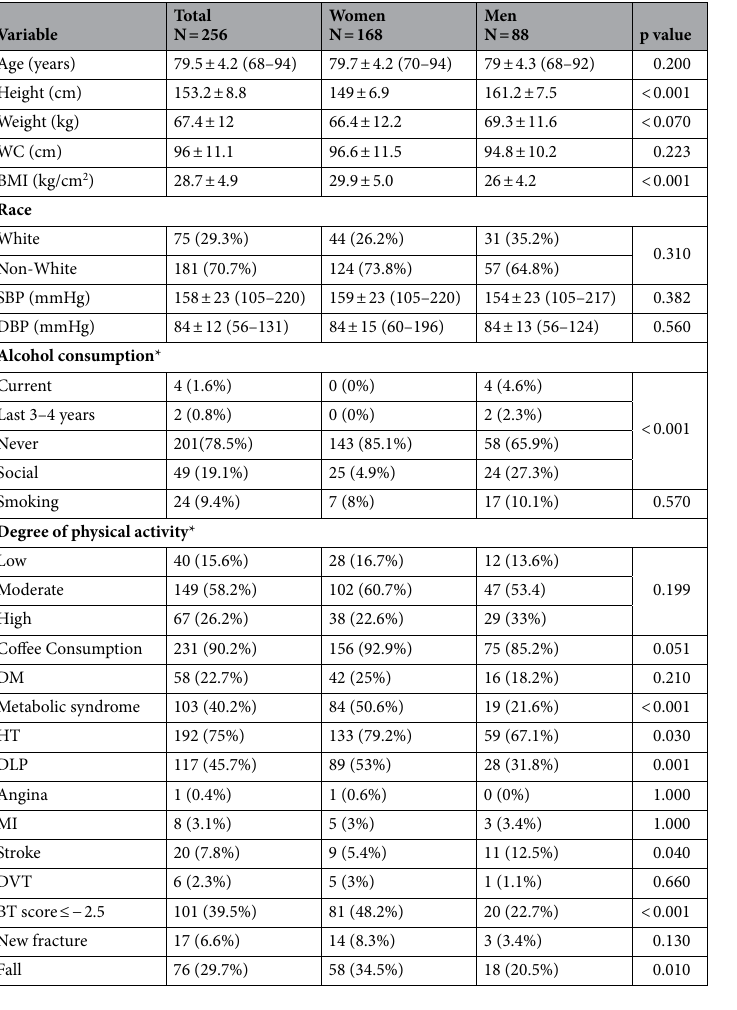
Table 1. Anthropometric and clinical characteristics of 256 older adults, separated by sex. Continuous variables are represented as the mean ± standard deviation ( t test); discontinuous variables are represented as the median and interquartile range (Mann–Whitney U test); binomial variables are represented as the number and percentage (Chi2 test); *Variables with Linkert scales were analyzed by the Mann–Whitney U test. WC waist circumference, BMI body mass index, SBP systolic blood pressure, DBP diastolic blood pressure, DM diabetes, HT hypertension, DLP dyslipidemia, MI myocardial infarction, DVT deep-vein thrombosis, BT score bone T